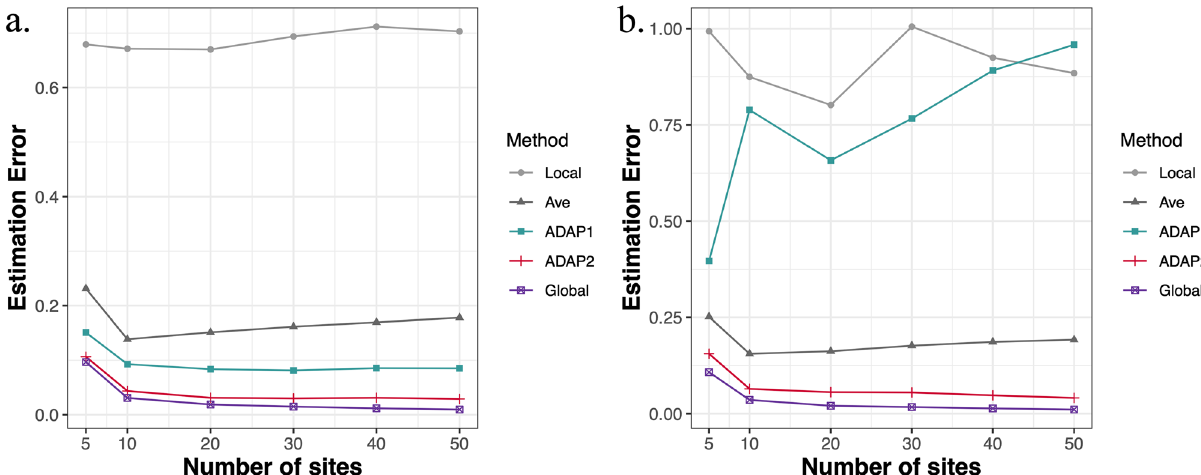
Figure 1. Simulation results under Setting 1 and Setting 2. Both plots display the change of estimation error averaged over 200 replications along with an increasing number of sites K . The panel ( a ) is for Setting 1, where covariates are generated from one shared multivariate normal distribution and the panel ( b ) is for Setting 2 where the heterogeneous covariates are